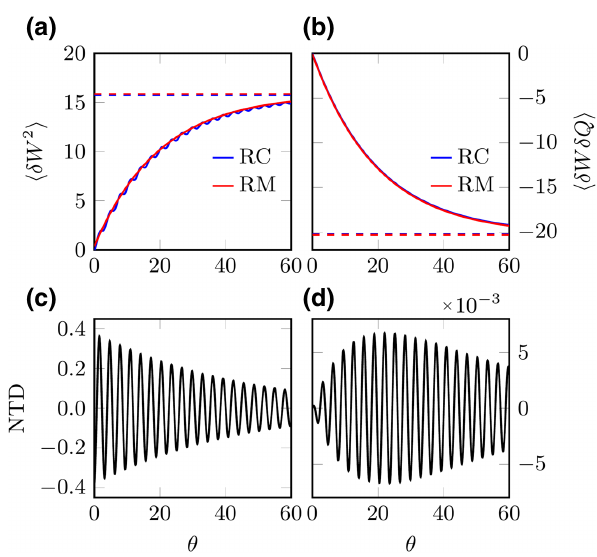
FIG. 2. Variance of work (cid:4) δ W 2 (cid:5) = (cid:4) W 2 (cid:5) − (cid:4) W (cid:5) 2 and the covariance of work and heat, (cid:4) δ W δ Q (cid:5) = (cid:4) WQ (cid:5) − (cid:4) W (cid:5)(cid:4) Q (cid:5) , for repeated contacts and repeated measurements for a single cycle as a function of the dimensionless time of contact with the heat baths, θ = (cid:11) h τ h = (cid:11) c τ c are drawn in (a) and (b), respectively. The dashed horizontal lines represent the asymptotic values in the perfect thermalization limit θ → ∞ . In both of the plots, the dif- ferences, which are almost imperceptible in (a) and (b), can be divided into two parts. The first part is the constant shift pro- portional to (cid:6) 2 in Eqs. (41) and (42). The remaining nontrivial differences (NTDs), which are plotted in (c) (for (cid:4) δ W 2 (cid:5) ) and (d) (for (cid:4) δ W δ Q (cid:5) ), result from the terms proportional to cos[2 (θ + ϕ) ] in Eqs. (40) and (41). The engine parameters are as follows: The initial half energy gap (cid:11) c = 1, the final half energy gap (cid:11) h = 3.7, and the Gaussian width of the measurement is (cid:6) = 0.2. The work strokes are characterized by α = 0.1 and ϕ = 0. The imper- fect thermalization strokes follow a master-equation